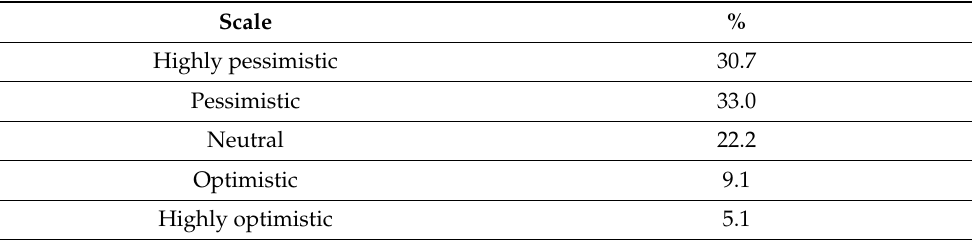
Table 10. Effect of COVID-19 on feelings/mood for younger men ( n =